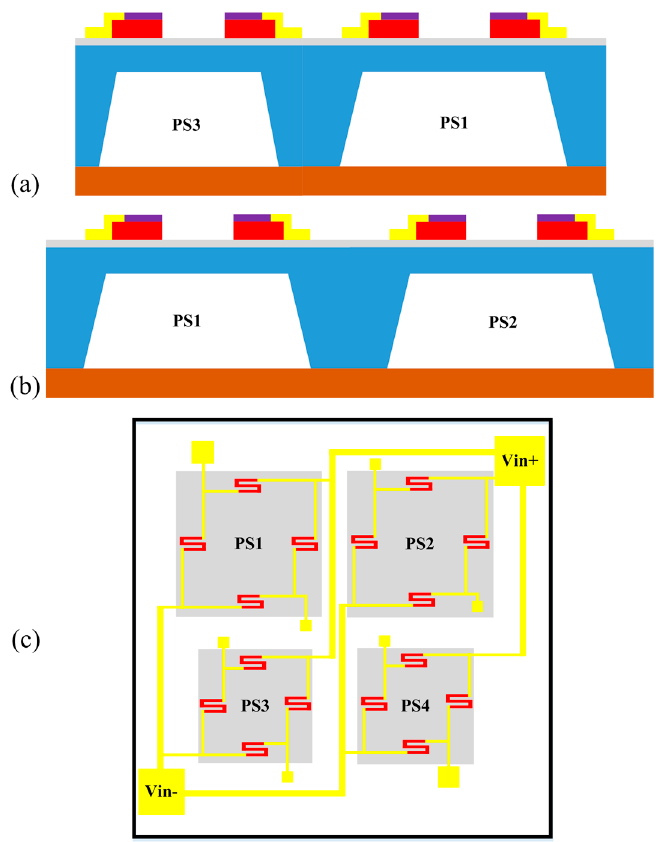
Figure 1. Schematic diagram of the array-type microelectromechanical system (MEMS) composite pressure sensor ( a ) side view of the array-type pressure sensor; ( b ) front view of the array-type pressure sensor; and ( c ) top view of the array-type pressure sensor.